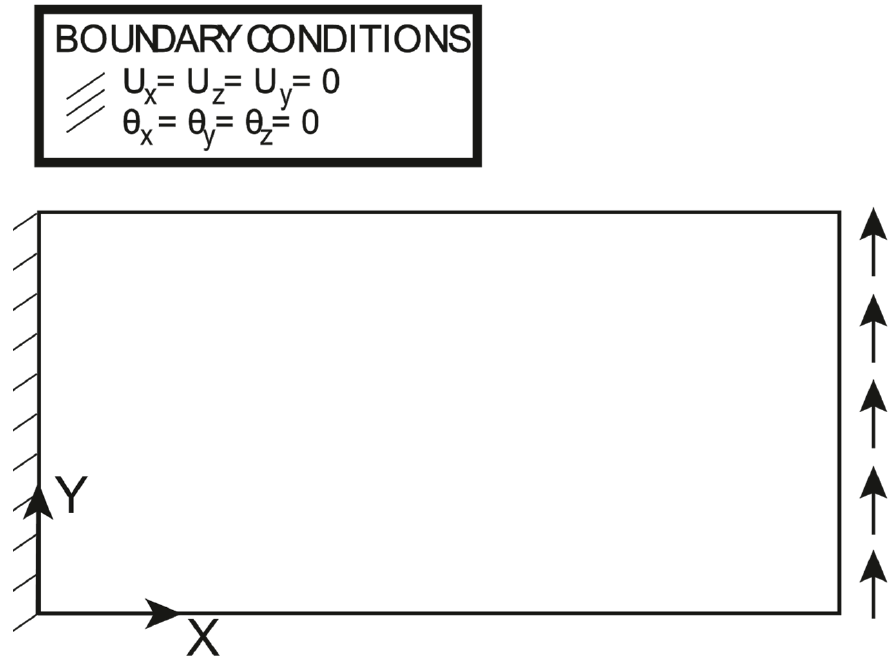
Figure 17. Shear loading: loading and boundary conditions. Figure 17 . Shear loading: loading and boundary conditions. Table 5. Shear loading: selected polynomial pre-extrapolation Table 5 . Shear loading: selected polynomial pre-extrapolation orders.